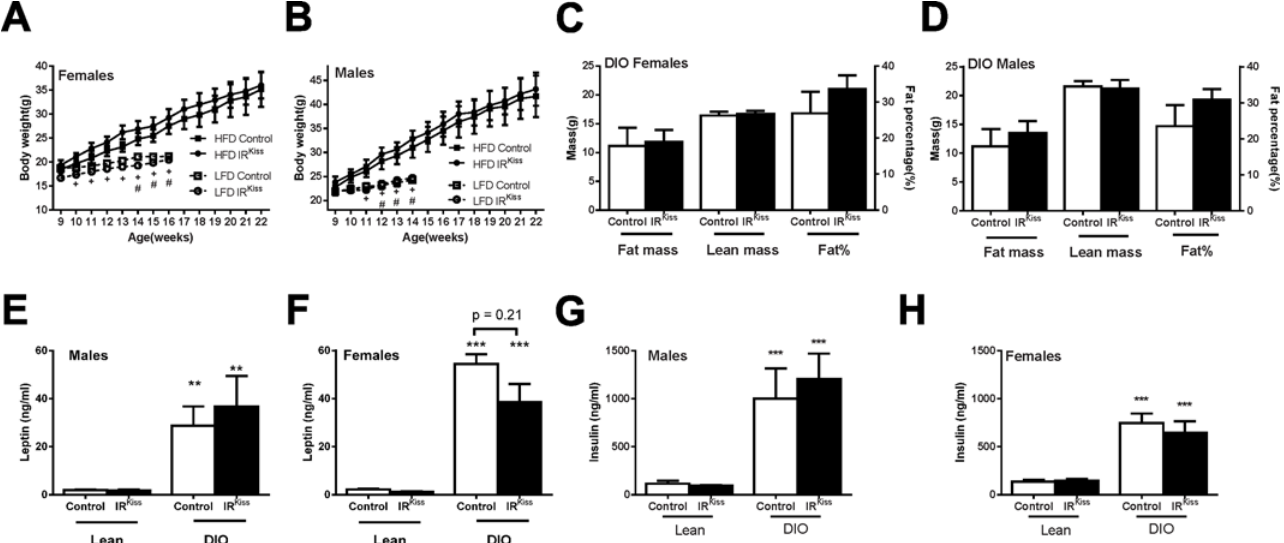
Fig 2. Metabolic parameters in IR Kiss mice after HFD treatment. (A) Female body weight growth curve after HFD (n = 8, 8). Body weights of a low-fat diet cohort included for comparison, + indicates control low and high fat diet groups differ significantly, # indicates IR Kiss low and high fat diet groups differ significantly, * indicates two HFD groups differ significantly. (B) Male body weight growth curve after HFD (Control, n = 7; IR Kiss , n = 5). Body weights of a low- fat diet cohort included for comparison. + indicates control low and high fat diet groups differ significantly, # indicates IR Kiss low and high fat diet groups differ significantly. (C) Female body composition measured by NMR 3 months after HFD (n = 8, 8). (D) Male body composition measured by NMR 3 months after HFD (n = 7, 5). (E) Serum leptin levels in lean males (n = 16, 8) and males after 3 months of exposure to HFD (n = 7, 4) (F) Serum leptin levels in lean females (n = 7, 7) and females after 3 months of exposure to HFD (n = 4, 9) (G) Serum insulin levels in lean males (n = 11, 10) and males after 3 months of exposure to HFD (n = 6, 5) (H) Serum insulin levels in lean females (n = 9, 10) and females after 3 months of exposure to HFD (n = 3, 9).